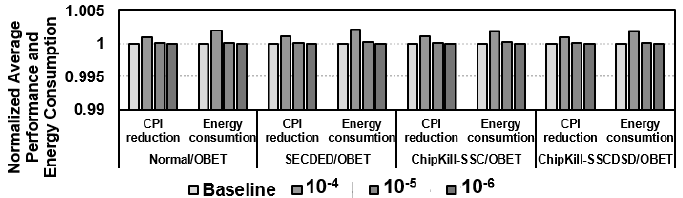
Figure 11. Comparison of performance and energy consumption with different codeword error